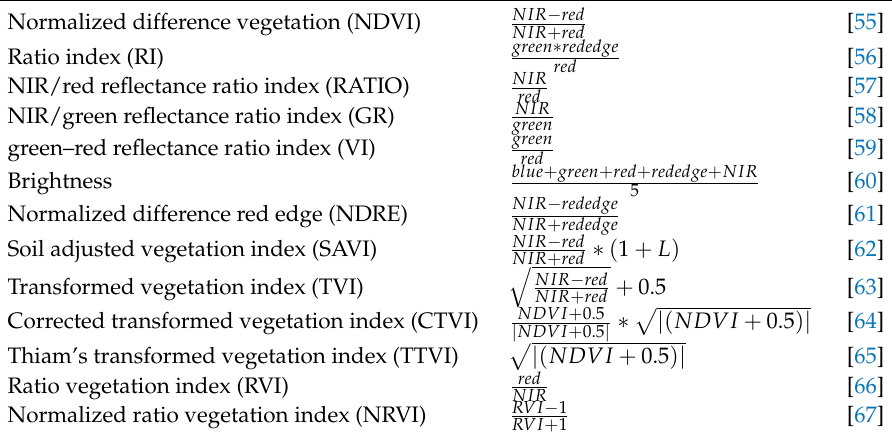
Table 2. Applied vegetation indices in this